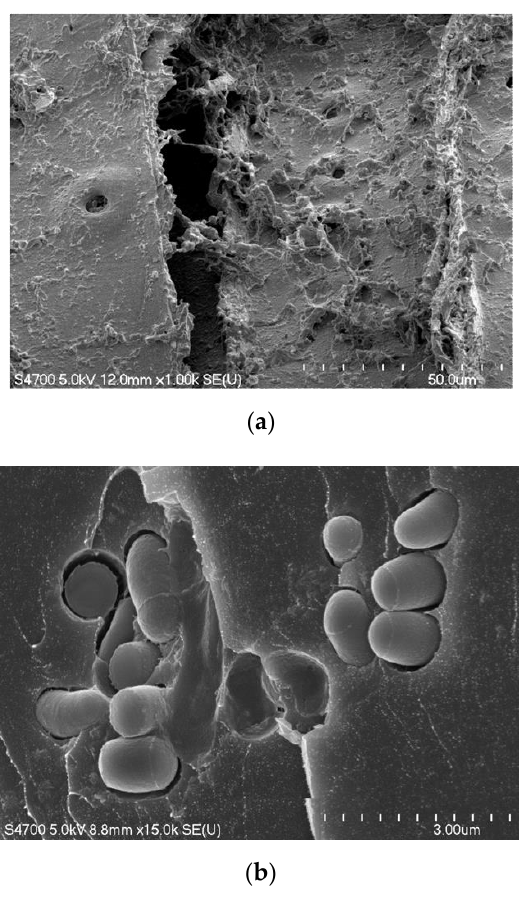
Figure 2. SEM images of Rhodococcus cells immobilized ( a ) on hydrophobized sawdust [41] and ( b ) in granulated poly(vinyl alcohol) cryogel [63].